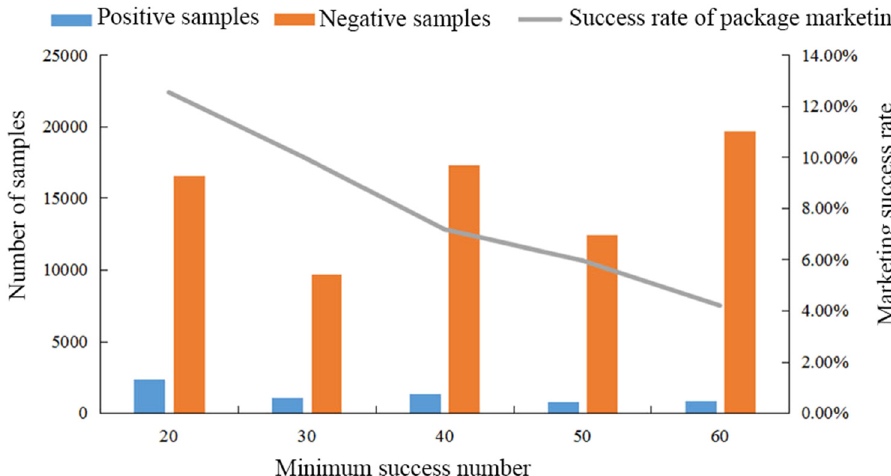
Figure 2: Marketing success rate under di ff erent minimum success number.